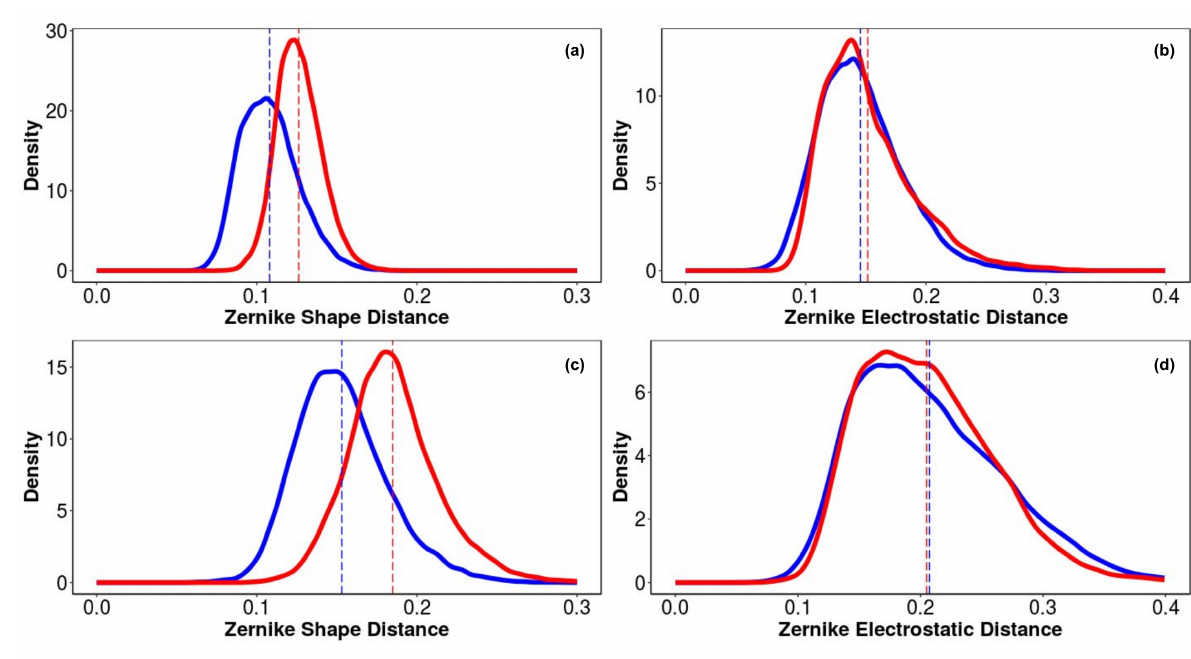
Figure 6. Density distribution of Zernike descriptors calculated for DTP3 and SCRB are reported. Shape and electrostatic complementarity between DTP3 (blue lines) and SCRB (red lines) peptides with BP3 ( a , b ) and BP4 ( c , d ) pockets of the MKK7 surface.